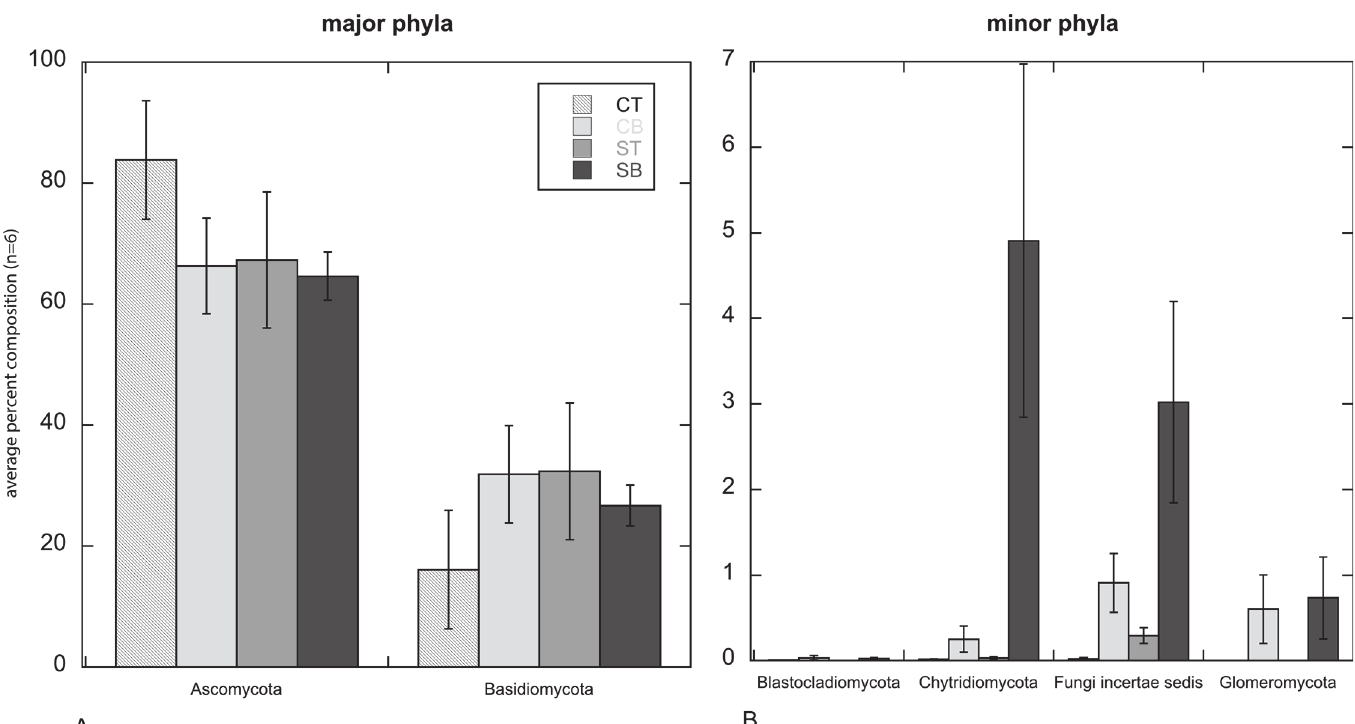
Figure 2. The average percentage of sequences for each soil interval that classified within a particular fungal phylum ( n = 6 ± 1 standard error). Soil intervals are designated as CT (cheatgrass 0 – 4 cm), CB (cheatgrass 4 – 8 cm), ST (sagebrush 0 – 4 cm) and SB (sagebrush 4 – 8 cm). Where bars are absent, the phylum was absent from all replicates.